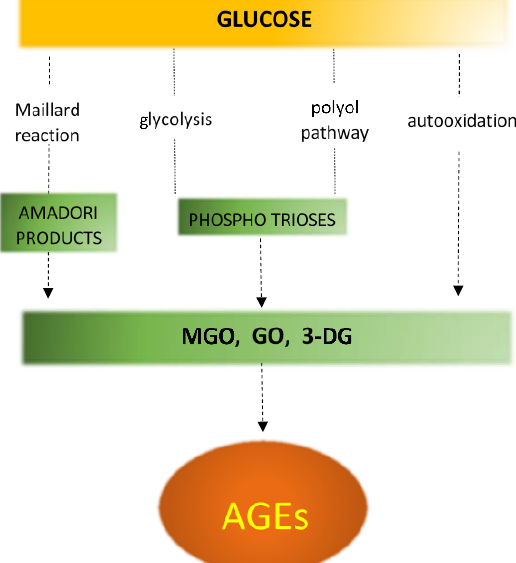
Figure 6. Different mechanisms of AGE formation. MGO—methylglyoxal, GO—glyoxal, 3-DG—3-deoxyglucosome. Initial, intermediary and terminal steps are shown in yellow, green and orange, respectively. Dotted arrows and lines represent multiple-step